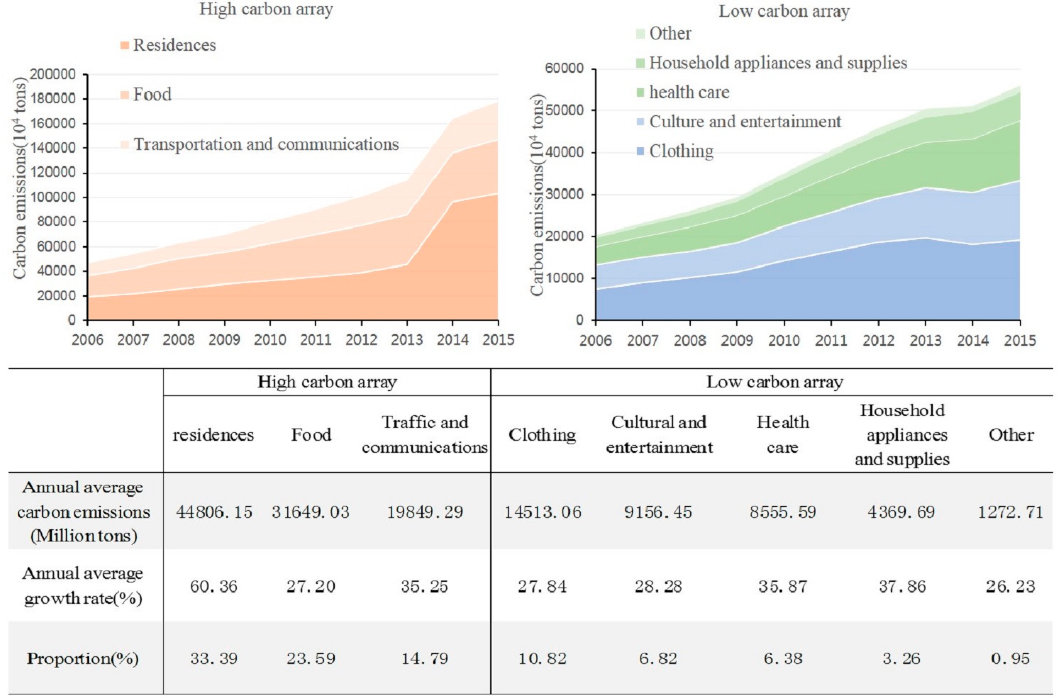
Figure 5. The change in products carbon emissions of eight consumer goods.